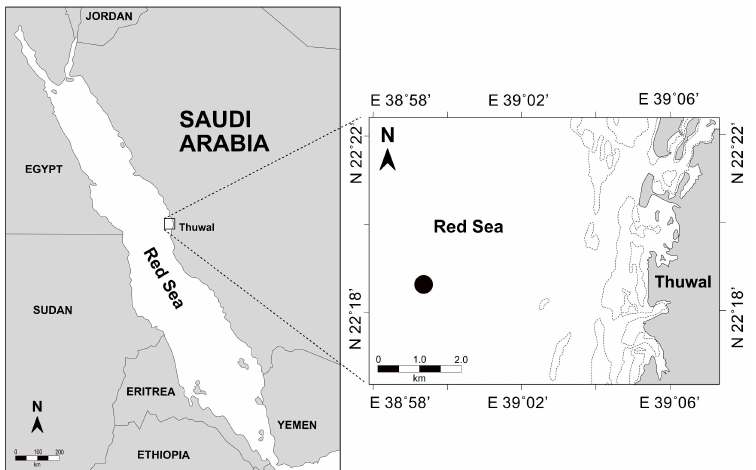
Figure 1. Location of the sampling station in the central coastal Red Sea (Saudi Arabia) where samples were collected from 2016 to